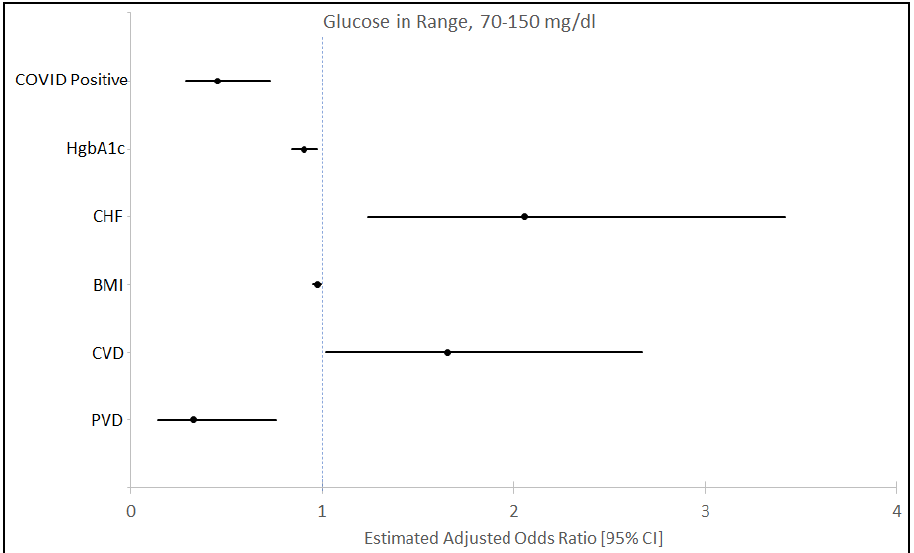
Figure 2. Multivariate analysis with odds ratio (OR) and confidence interval (CI) for time in range (TIR) 70–150 mg / dL in the study population. Other variables adjusted but did not show significance were gender, age, race, myocardial infarction, arrhythmias, chronic lung diseases, and respiratory interventions during the hospital stay and medications like insulin, pressors and steroids. PVD—Peripheral Vascular Disease, CVD—Cerebro Vascular Disease, BMI—Body Mass Index, CHF—Congestive Heart Failure.